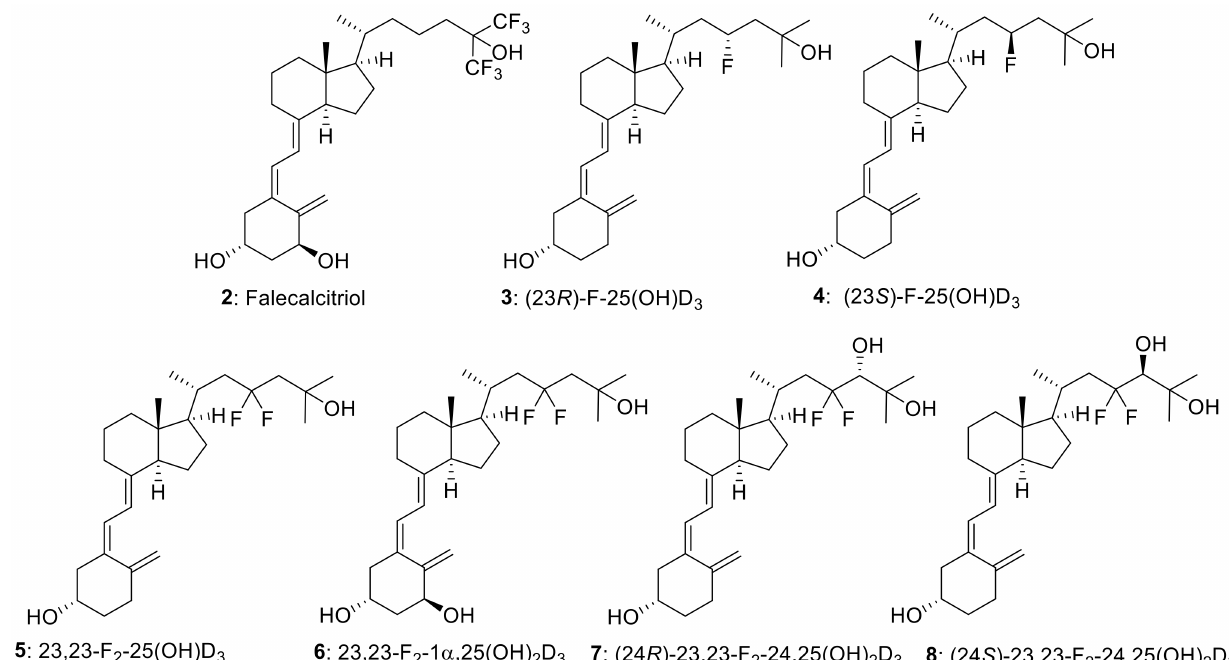
Figure 1. Structures of Falecalcitriol ( 2 ) and C23-fluorinated vitamin D 3 analogues ( 3 – 8